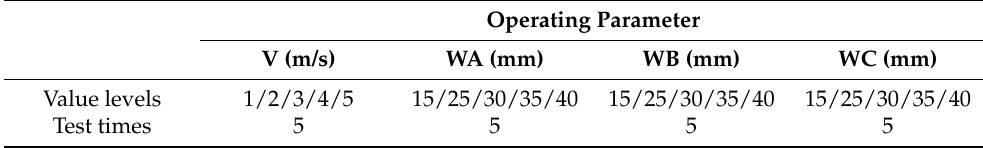
Table 3. Single-factor experiment design of operation